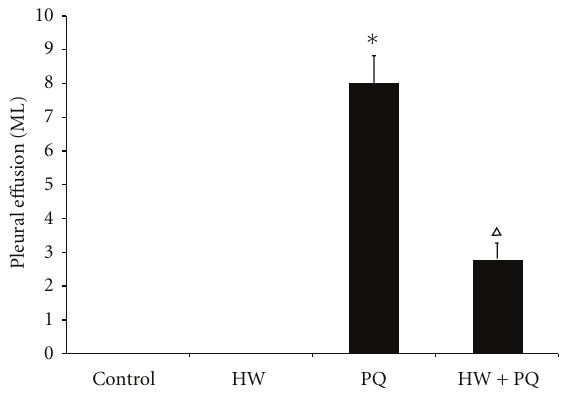
Figure 3: MDA in lung tissue. Our results demonstrated that paraquat increased lung MDA levels. In contrast, MDA levels were lesser in PQ + HW group ( ∗ P < . 01 compared to control; (cid:2) P < . 01 compared to PQ group). Table 1: E ff ects of saturated hydrogen saline on LDH, total cells, and protein concentration in BALF. Rats exposed to paraquat exhibited significant increase in the LDH level in BAL fluid compared to rats in the control group, whereas a significant rather less of increase of LDH in BAL fluid was observed in PQ + HW group compared to those in PQ group. Total cells and protein concentration in the BAL fluid were determined as an indicator of lung hyperpermeability induced by paraquat. Our results showed that total cells and protein in BALF in PQ group were significantly increased compared to control group ( P < . 01). In contrast, rats in PQ + HW group demonstrated a significant lesser increase in total cells and protein ( ∗ P < . 01 compared to control; (cid:2) P < . 01 compared to PQ